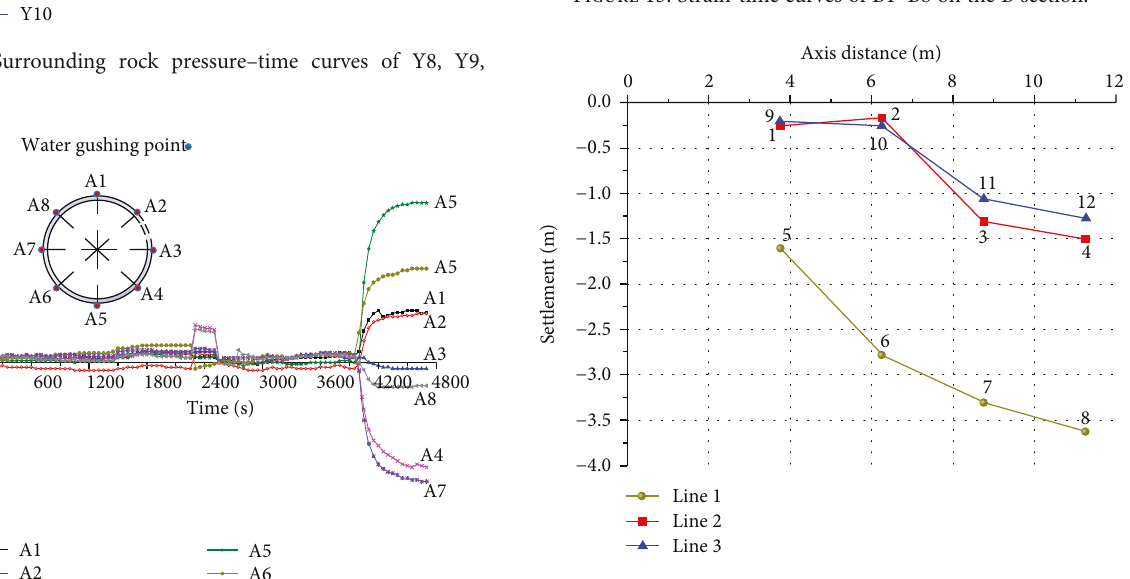
Figure 16: Surface subsidence